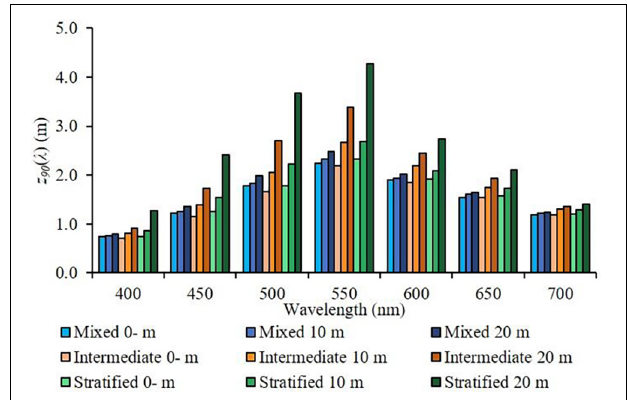
FIGURE 5 | Spectral variability of optical depth ( z 90 ( λ ) ) at the surface layer, 10 m depth and 20 m depth in different situations of stratification.